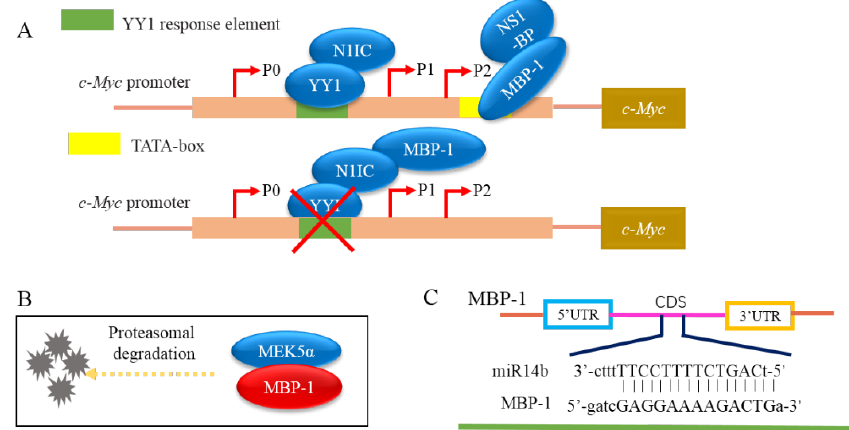
Figure 4. The schematic diagram of interactions between MBP-1 and proteins or miRNA. ( A ) The binding of NS1-BP with MBP-1 increases the inhibitory effect of MBP-1 on c-Myc promoter activity; the combination of MBP-1 and NI1C/YY1 complex attenuates the binding ability of NI1C/YY1 complex to c-Myc promoter. The red cross represents that the N1IC/YY1 complex doesn ’ t bind to the YY1 response element. ( B ) MBP- 1 destabilizes MEK5α. ( C ) The binding sequence of MBP-1 and miR14b.